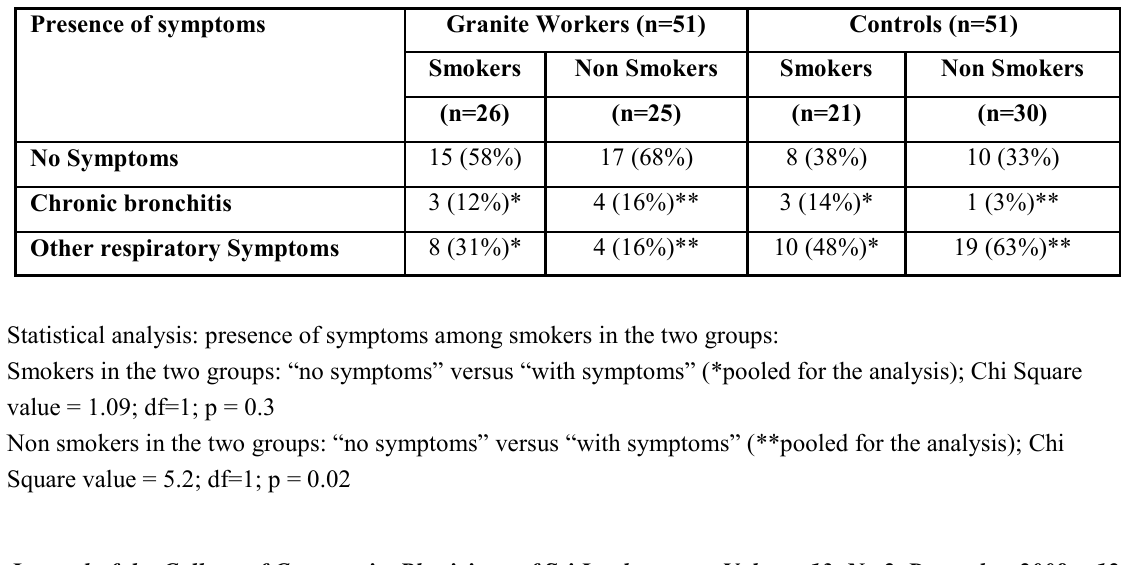
Table 4 – Comparison of respiratory symptoms among smokers and non smokers in the two groups